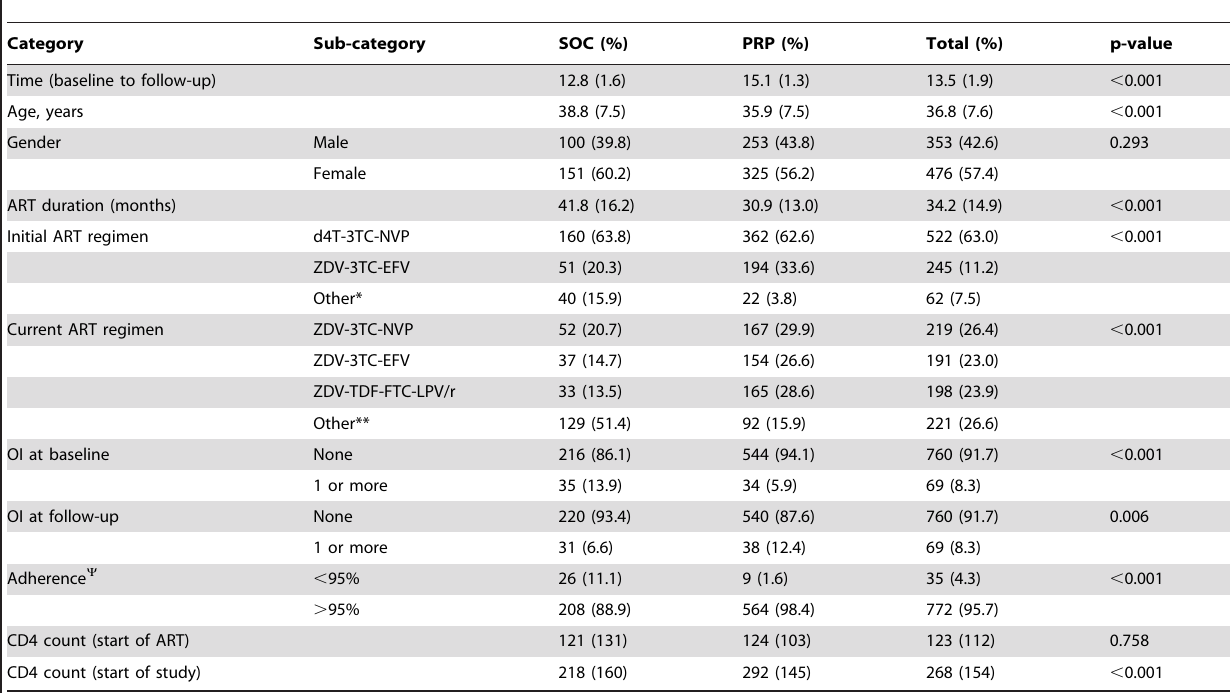
Table 1. Demographic, clinical and laboratory characteristics of the study population by method of follow-up a